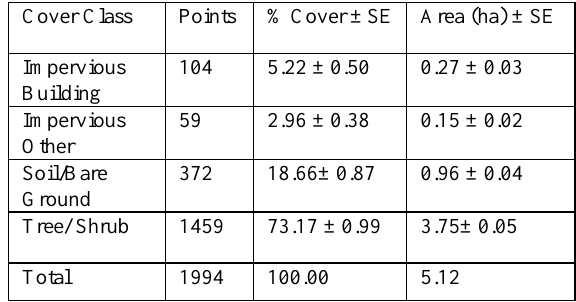
Table 3 . Land cover classes of Arapsuyu